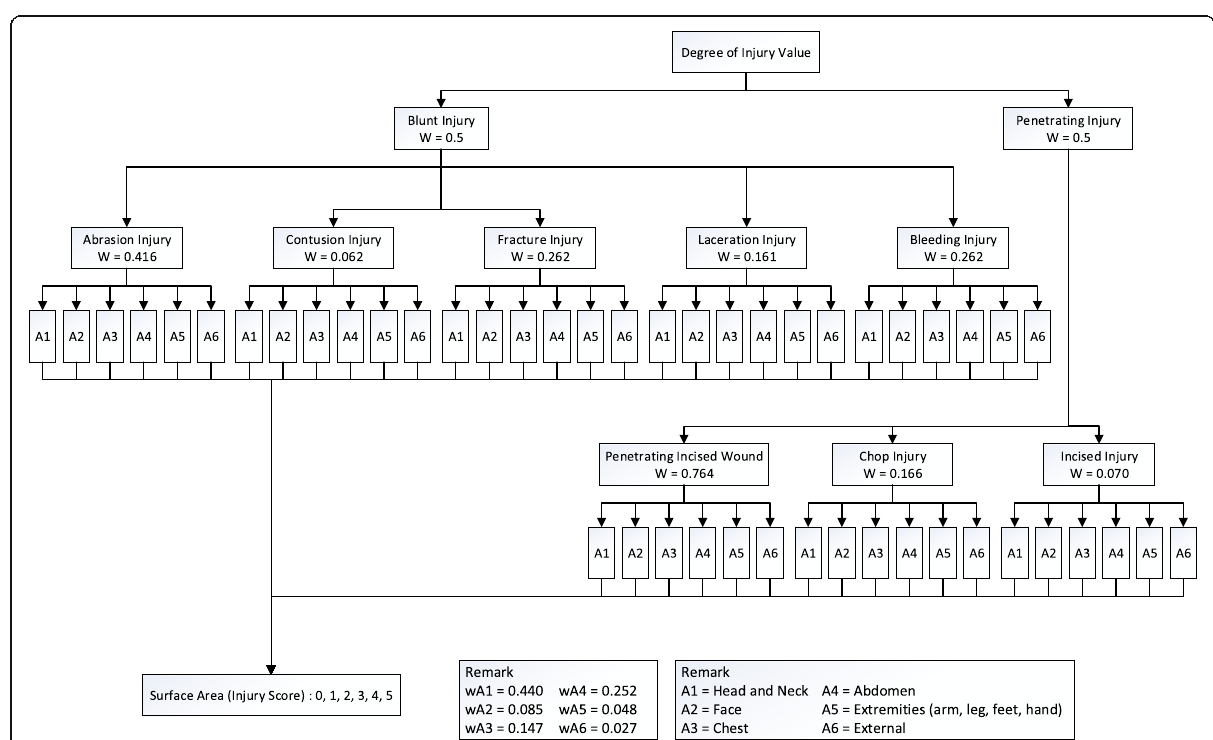
Fig. 1 Weight Value for Criteria and Indicators Degree of Injury Using AHP. All the criteria and indicators, it was classified into two types: penetrating injury and blunt injury. Sex, Age, Glasgow Coma Scale, Systolic Blood Pressure and Respiration Rate evaluated with the Analytical Hierarchy